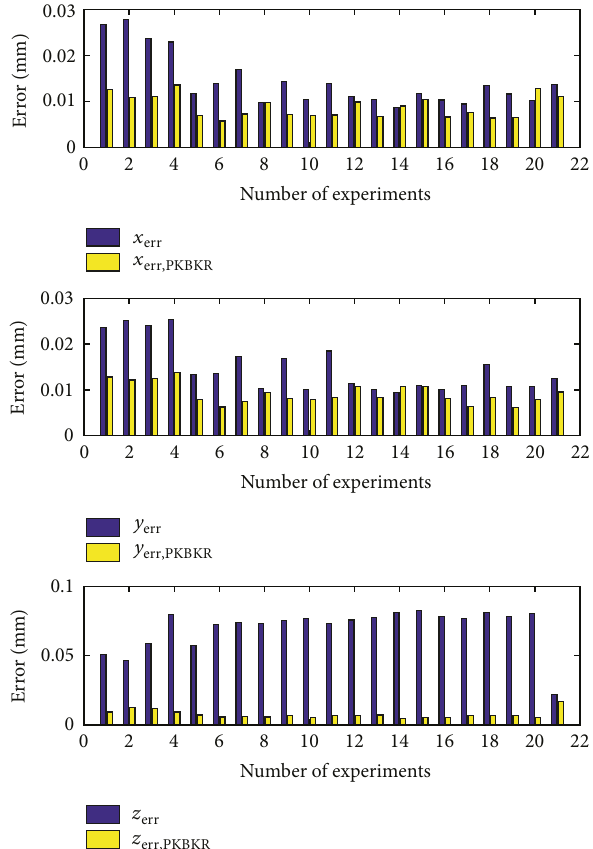
Figure 5: Displacement estimation errors. All directions and all 21 experiments.